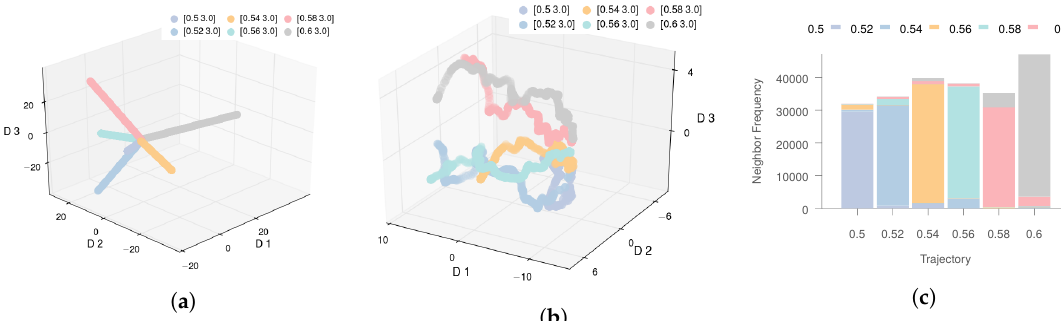
Figure 6. Six trajectories with fixed χ = 3.0 and the variable φ ∈ { 0.50,0.52,0.54,0.56,0.58,0.6 } were selected to learn mapping and transform the data into three dimensions using ( a ) Isomap with k = 8 and ( b ) Entropy-Isomap with k = 8, (cid:98) H = 0.3. ( c ) Neighborhood cross-mixing given by Entropy-Isomap with k = 8, (cid:98) H = 0.3: for each trajectory Γ , neighbors of each point belonging to individual trajectories are aggregated and shown in stacked bar graph form. (Please view in color).